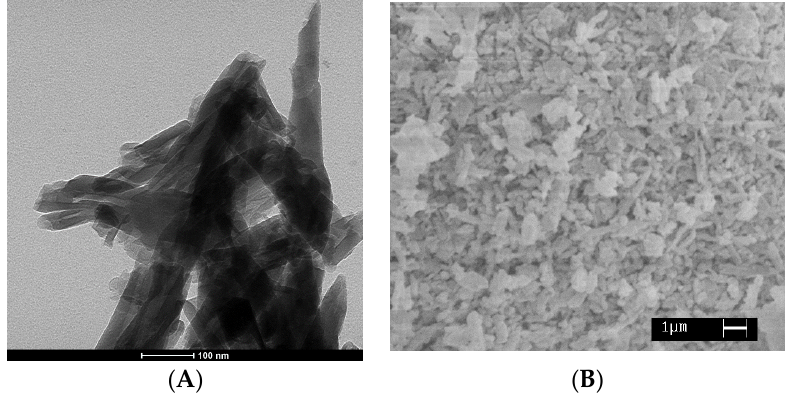
Figure 1. ( A ) TEM image of the pristine HNTs and ( B ) SEM micrograph of the HNTs ‐ lysozyme